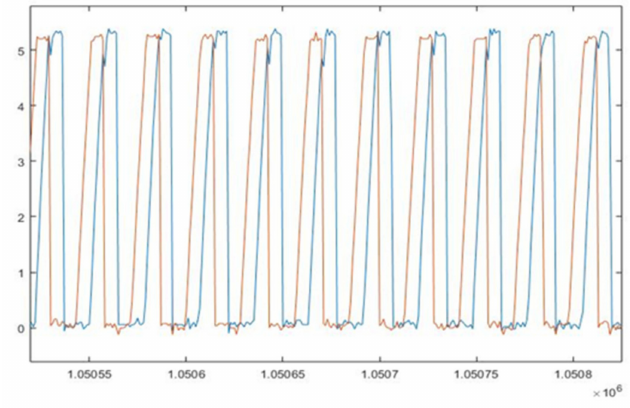
Figure 8. Optical sensor output channel: A—red,